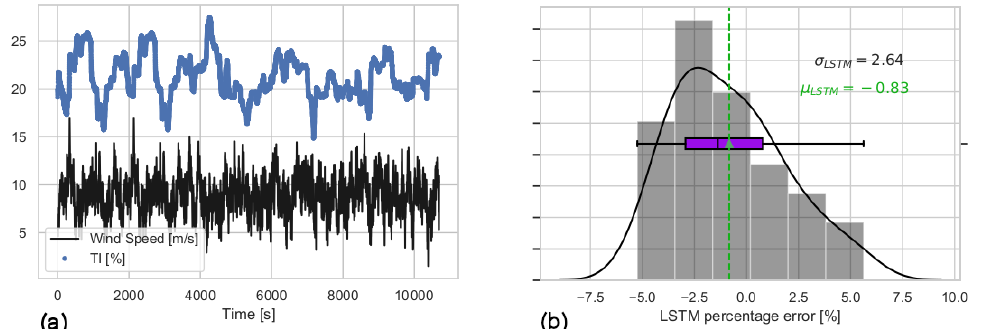
Figure 16. Input time series and 1min prediction error of the transfer learning LSTM network, higher-turbulence-intensity flow case. Mean wind speed = 9ms − 1 and TI = 20% over the 60min test case. (a) Time series of the inflow dataset for the higher-TI test of the transfer learning LSTM network, originally trained for mean wind speed = 9ms − 1 and TI = 10%. (b) The 1min average percentage error of the transfer learning LSTM model under higher